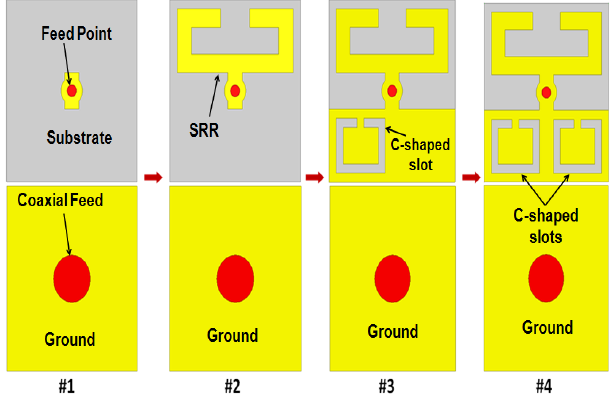
Figure 1. Proposed antenna design evolution